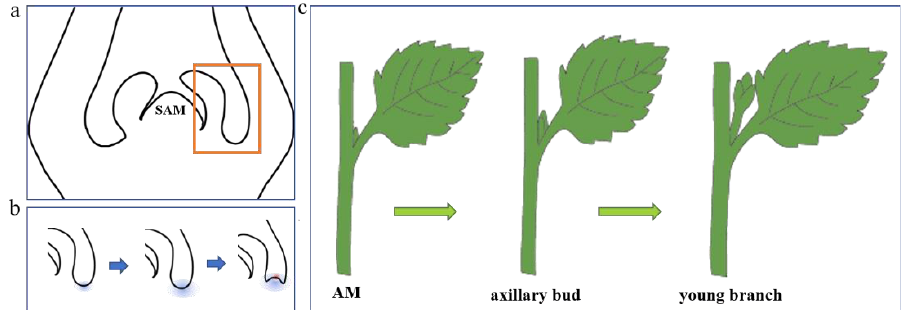
Figure 1. Steps of plant shoot branching. ( a ) indicates the axillary meristem at the leaf primordium axils. ( b ) indicates the formation of axillary meristems (area shown in yellow box in ( a )). ( c ) represents the development of plant axillary meristem into young branches.